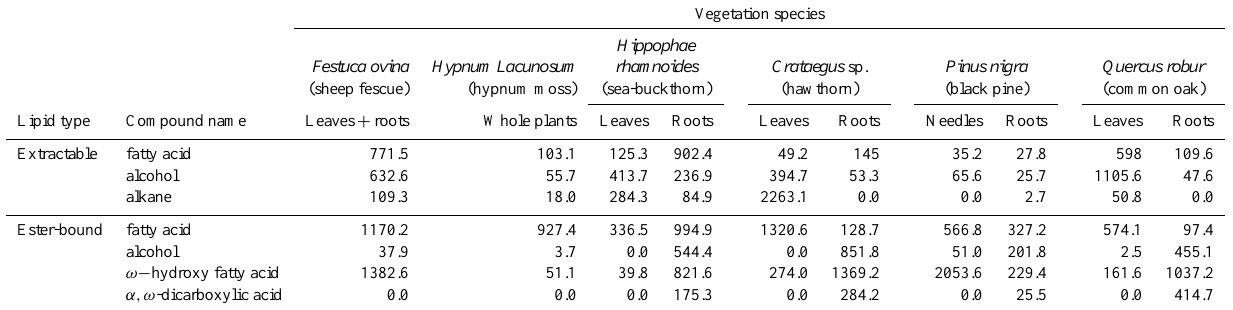
Table 4. The group abundances of both DCM/MeOH extractable lipids and ester-bound lipids upon BF 3 –MeOH hydrolysis of leaves and roots (µgg − 1 dried